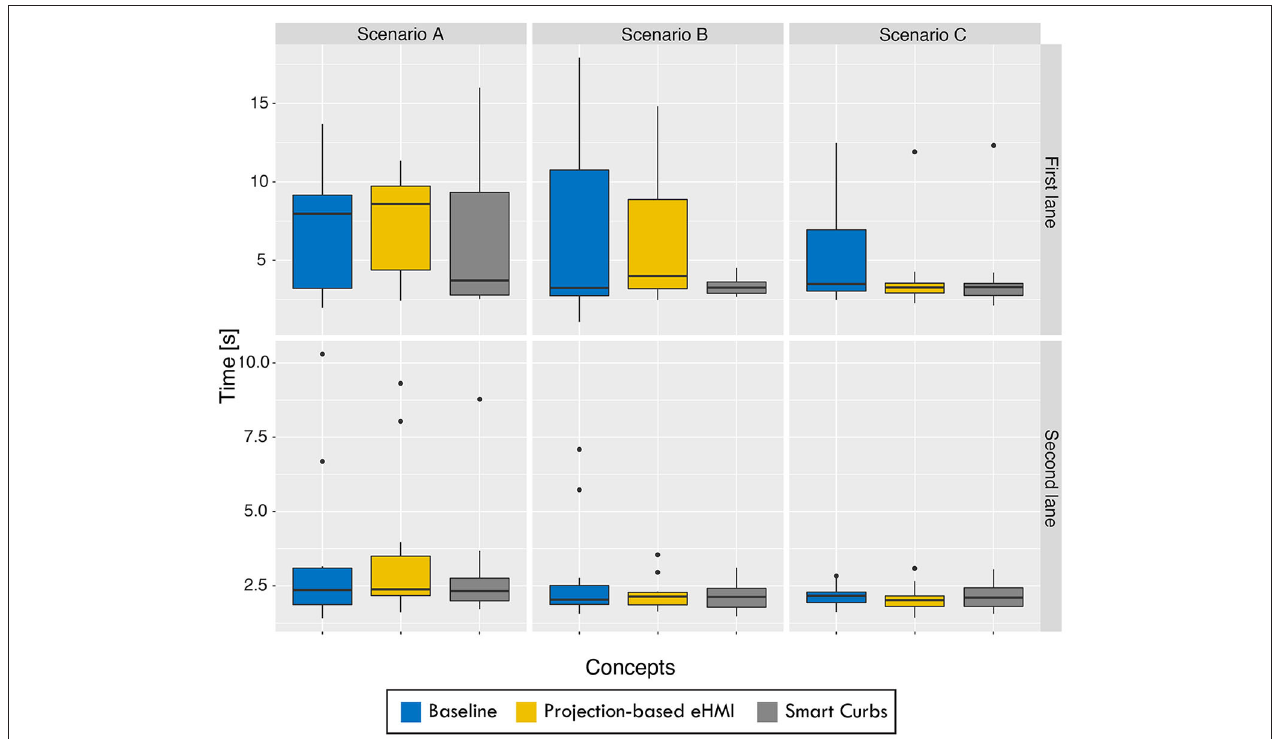
FIGURE 5 | Results of measured crossing duration (in s ) per lane and scenario as boxplot (with dots representing outliers). First lane and closer to the participant (top), second lane and farther away to the participant (bottom). Boxplots of participants’ crossing times in seconds for both lanes and the three experimental conditions. Interquartile ranges are between 1 and 5 seconds, with the first lane having a much broader variance in crossing times among all conditions. For the second lane, Base and Projection conditions show the most